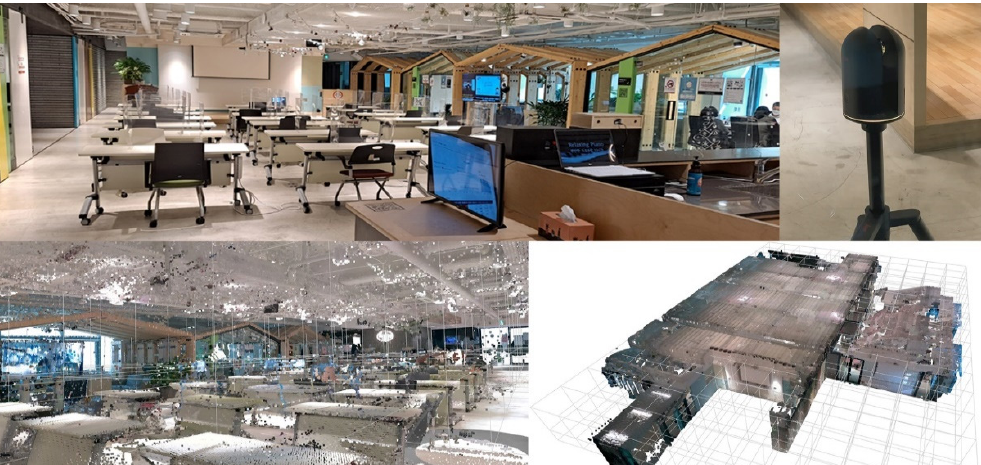
Figure 8. Leica BLK 360 imaging laser scanner scans the indoor space. The voxel database of point clouds is divided on the basis of the voxel size. This is a figure, the schemes follow the same formatting.